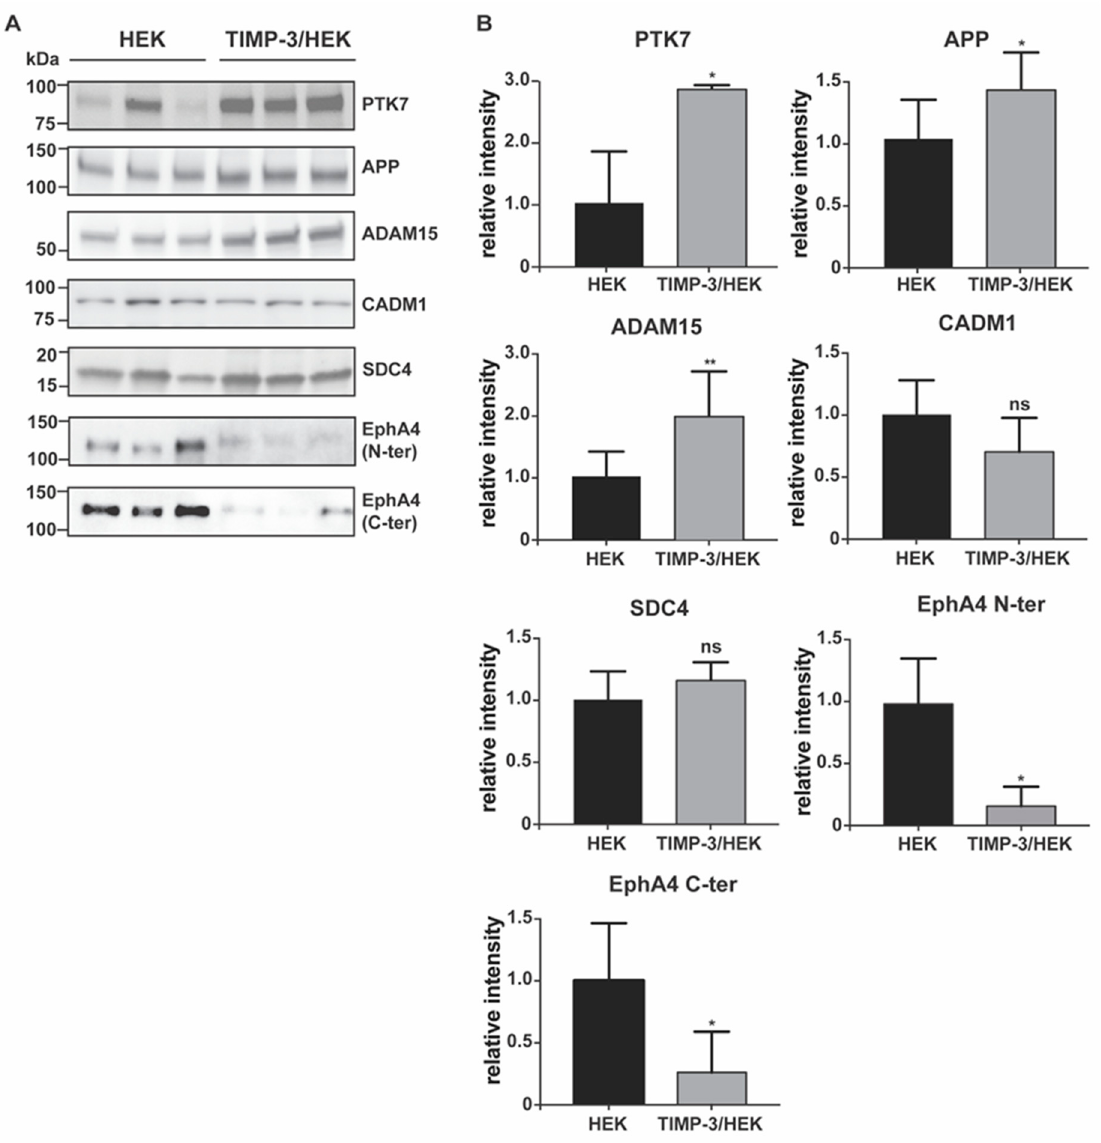
Figure 3. Validation of TIMP-3/HEK cell membrane proteome analysis by immunoblotting. Immunoblots ( A ) and their respective quantification ( B ) showing levels of PTK7, APP, ADAM15, CADM1, SDC4, and EphA4 in membrane proteins isolated from TIMP-3/HEK and control HEK 293 cells, (densitometric quantifications shown as mean values ± standard deviation; * p < 0.05, ** p < 0.01, Student’s t-test; from 3 to 6 separate experiments have been performed and analyzed).